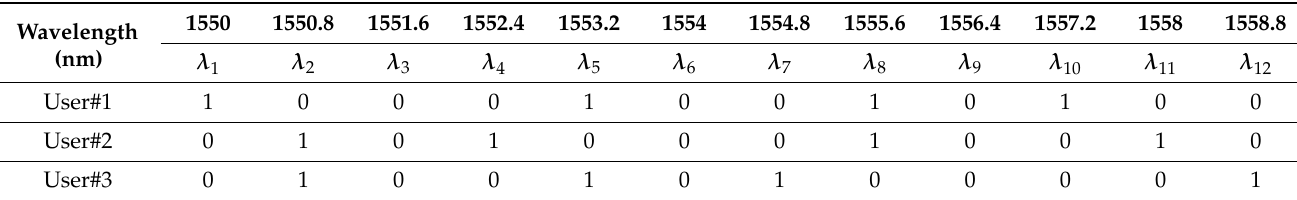
Table 3. Wavelengths assigned to three users using DPS encoder.